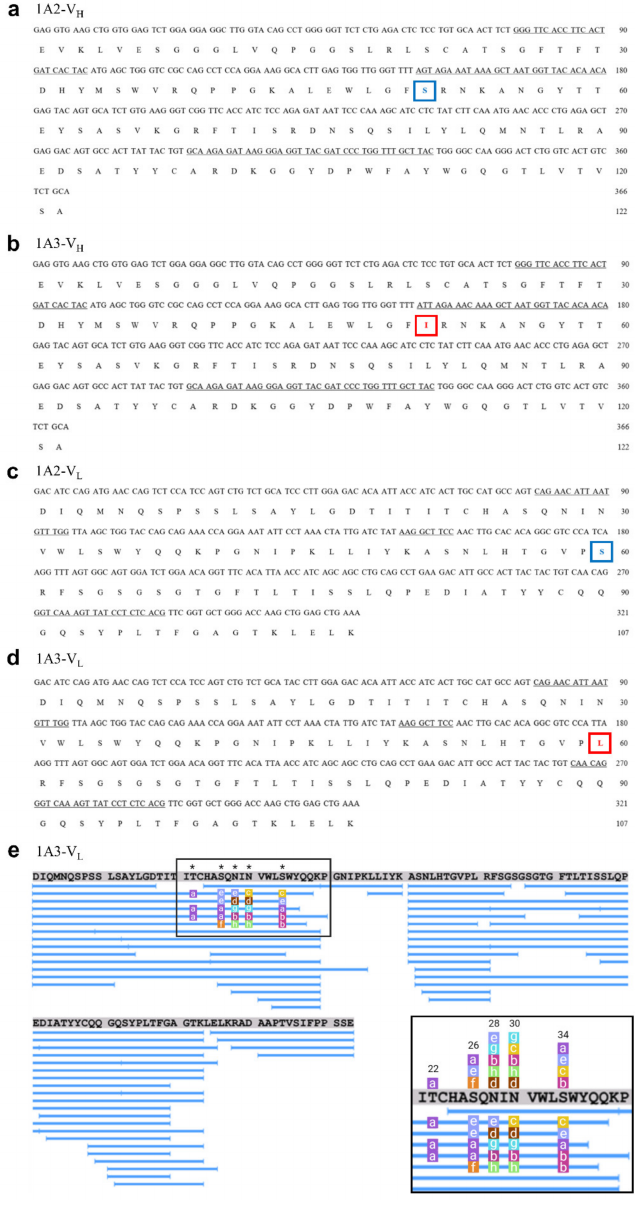
Figure 2. DNA and amino acid sequences of the mAb variable regions. The amino acids differentiat- ing the unspecific 1A2 and specific 1A3 mAbs are highlighted. ( a ) V H of 1A2, ( b ) V H of 1A3, ( c ) V L of 1A2, ( d ) V L of 1A3. ( e ) The coverage of 1A3 variable regions by peptides detected in LC-MS/MS analysis, and the position and type of the detected glycans. Details of attached glycans are given in the inset at the bottom